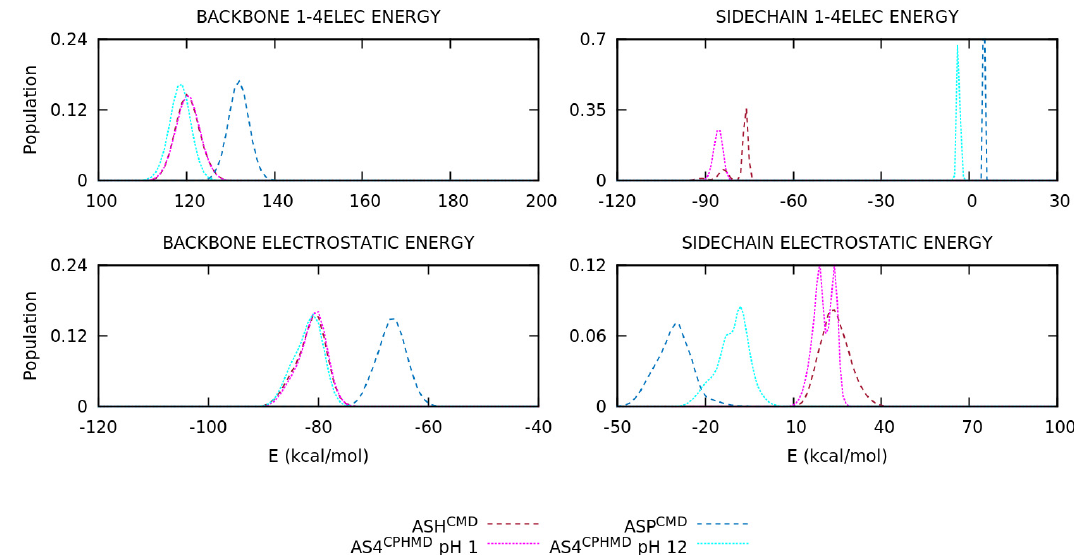
Figure 10. Energy distribution of the 1–4 and long-range electrostatics of the backbone and side chain atoms of the blocked Asp 2 tripeptide. Dotted and dashed lines are CPHMD and CMD simulation methods, respectively.